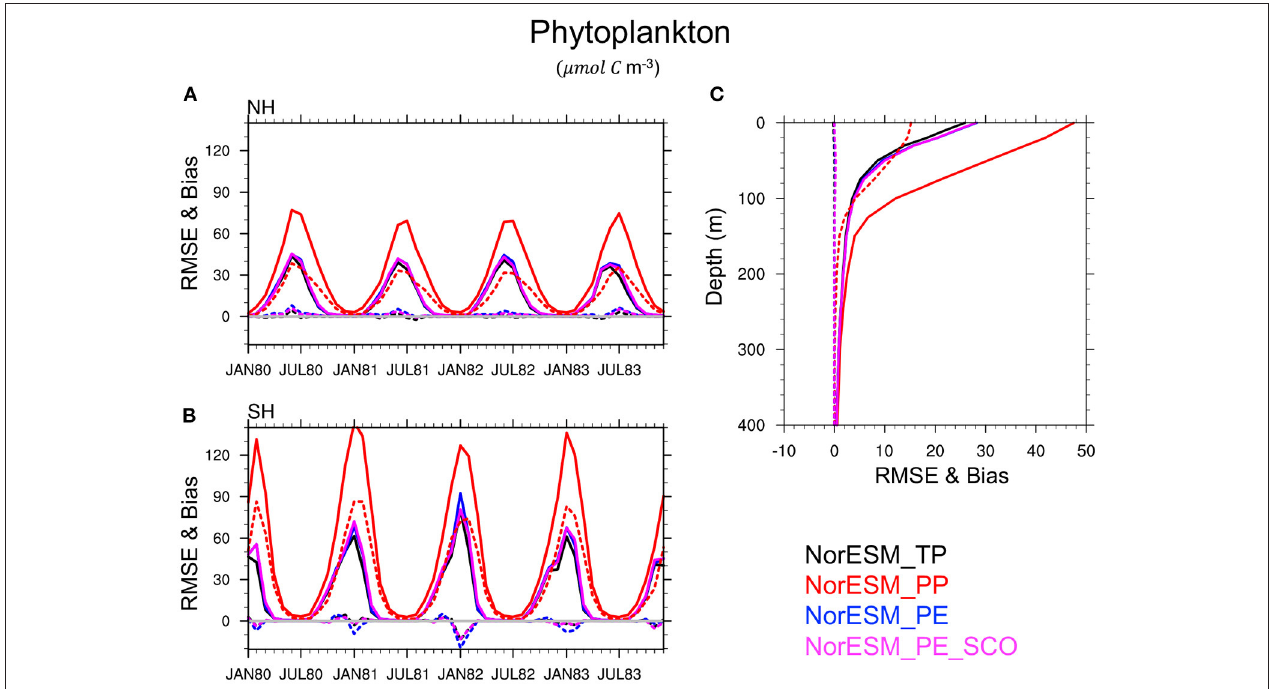
FIGURE 7 | Panels on the left show the RMSE (solid lines) and bias (dotted lines) of the ensemble mean of NorESM phytoplankton concentration compared to the TRUTH in the euphotic zone (i.e., from the surface to 100 m) in the northern hemisphere [NH, (A) ] and in the southern hemisphere [SH, (B) ]. (C) is the globally averaged vertical error profiles estimated over the 4-year period (1980–1983). The results of the free NorESM simulation using TP are shown in black, PP in red, and PE using assimilation of time-varying observations in blue and sparse climatological BGC observations in